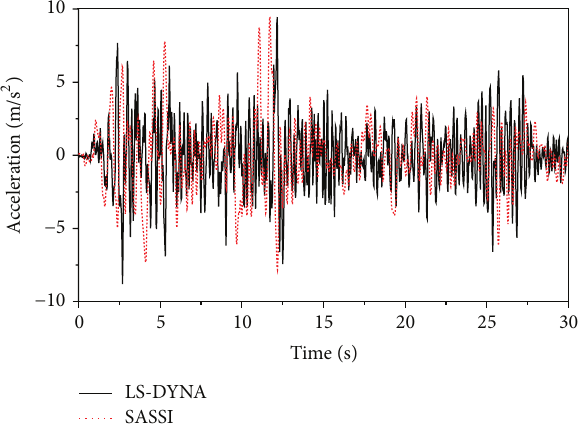
Figure 3: FE model of SASSI.